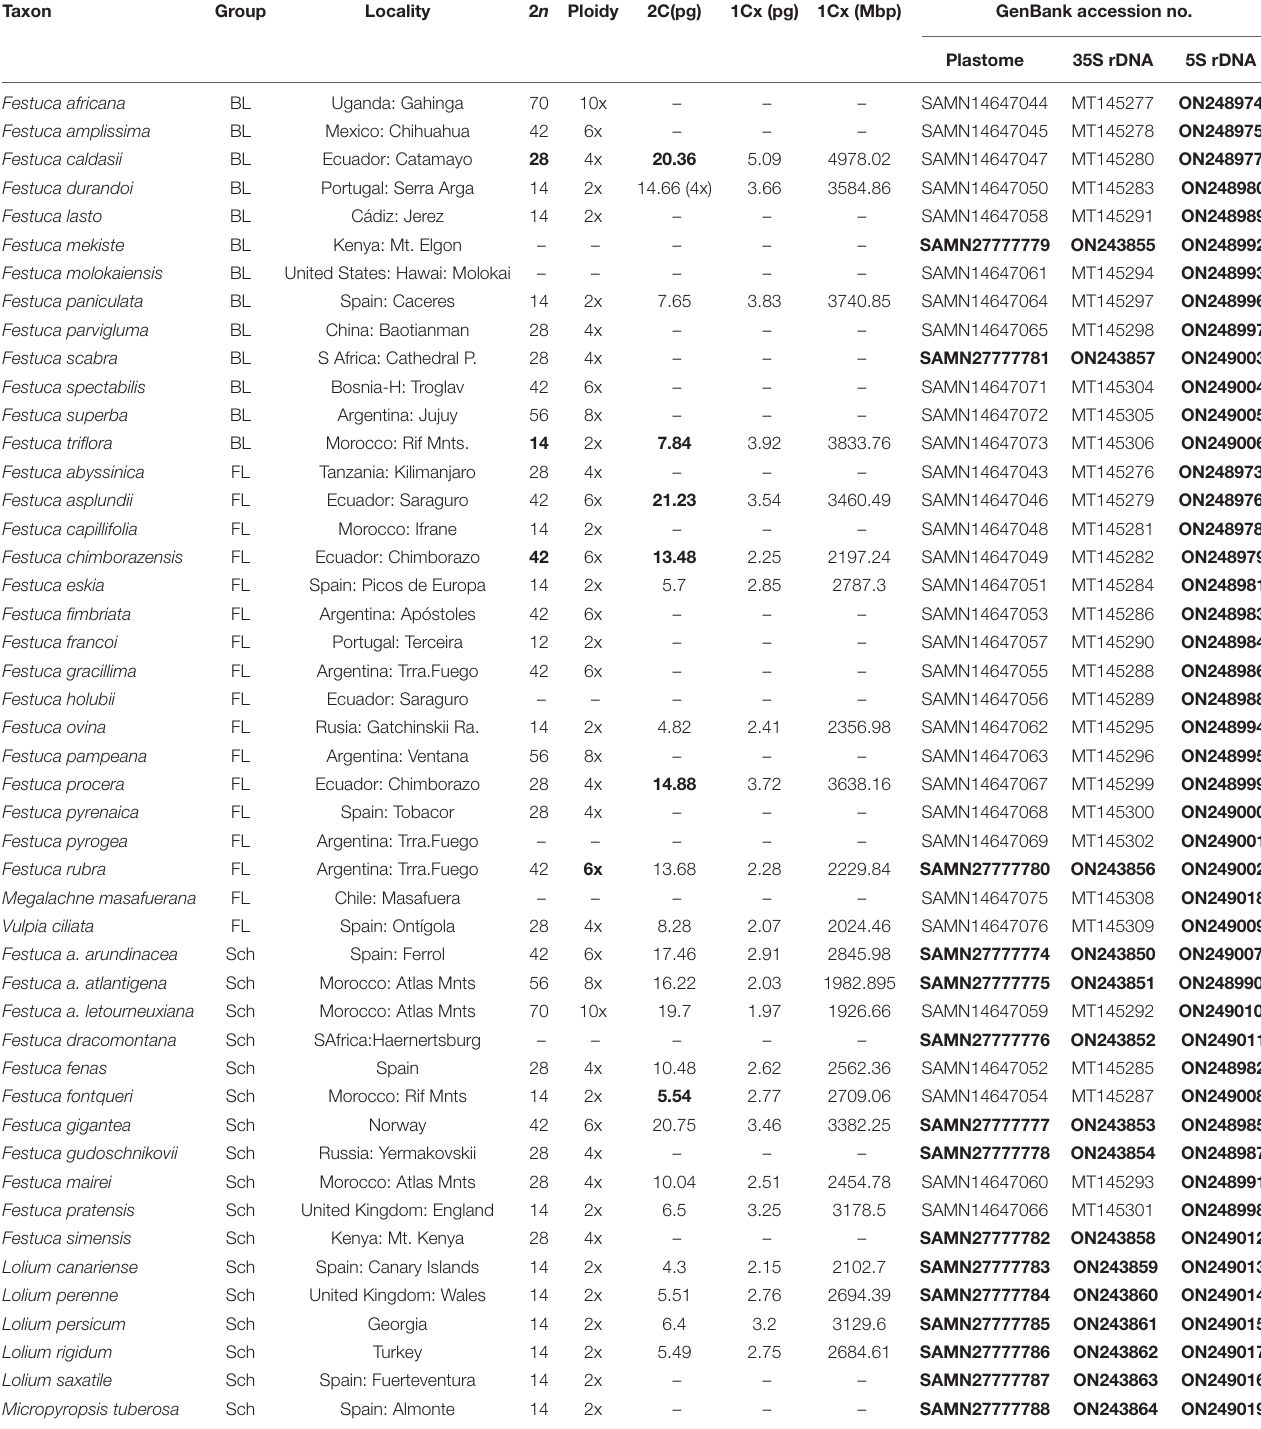
TABLE 1 | Taxa included in the repeatome analysis of